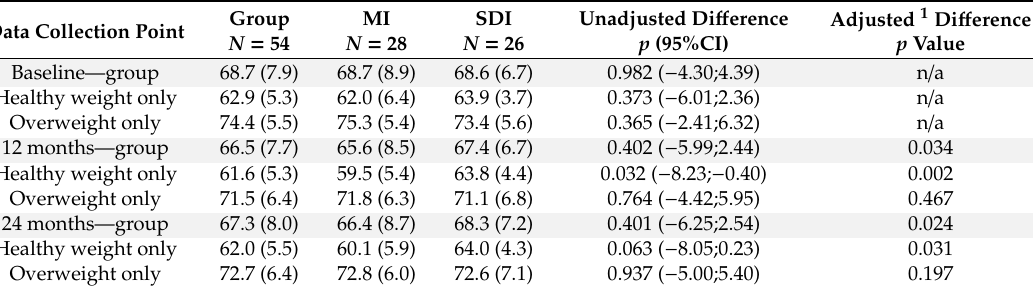
Table 2. Mean (SD) weight (kg) showing weight change according to intervention type and baseline BMI category (healthy weight and overweight) using intention to treat (ITT) analysis on 54 participants.